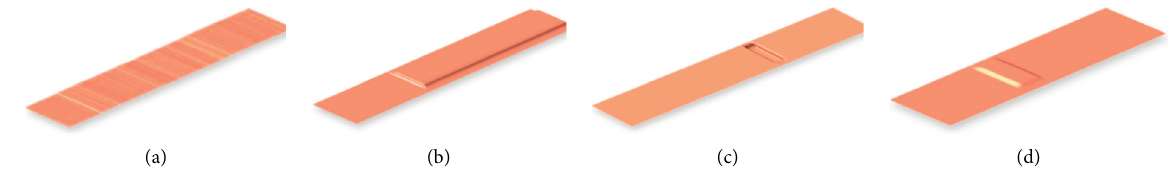
Figure 8: Typical pavement simulation model. (a) Uneven pavement. (b) Vertical wall. (c) Trench. (d) Automobile